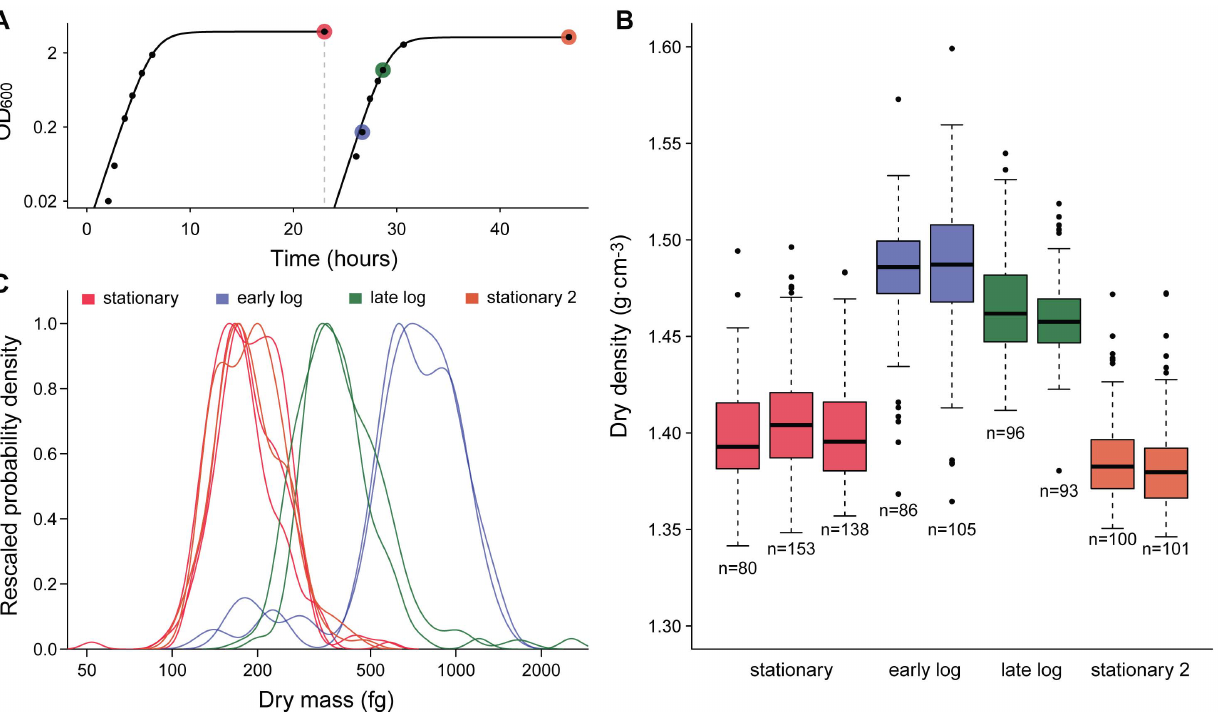
Figure 2. Dry density and dry mass of a bacterial culture. a) Growth curves of E. coli cultures. A culture was grown for 24 hours, diluted 1000- fold, and allowed to grow again for 24 hours. Samples from the cultures were fixed for analysis at the colored time-points. Solid line is the fit to logistic growth model. b) The dry density of the culture by sampling time point. Technical replicates of these fixed samples show that the changes in density are reproducible and not attributable to instrument error. c) Probability distributions of dry mass, rescaled so that the modal mass had a density of one. Lines of the same color are technical replicates, measured several days apart.